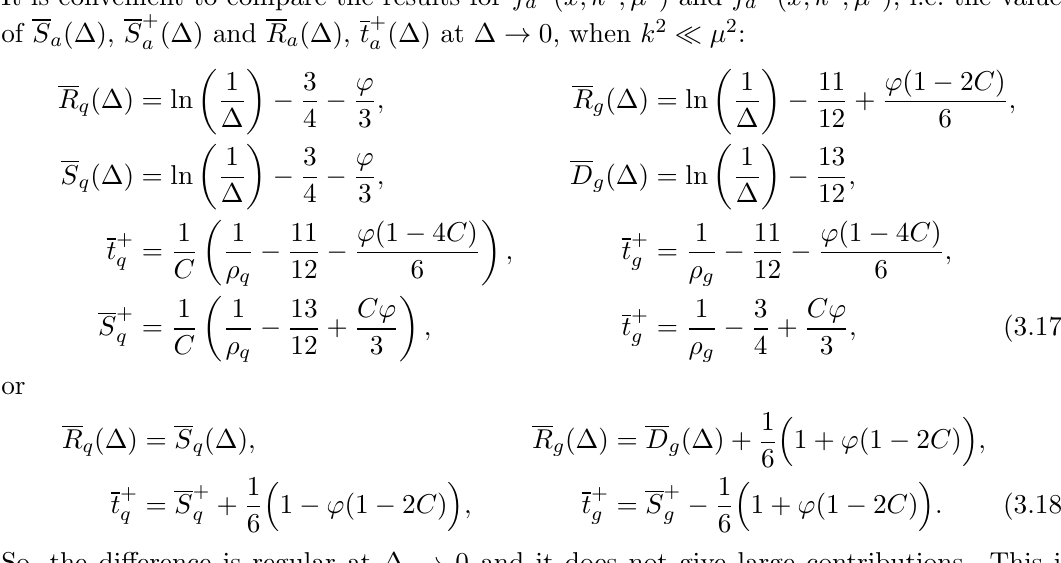
Figure 1 . The ratio of the TMD gluon densities in a proton obtained using integral and di(cid:11)erential formulation of the KMR approach as a function of the gluon transverse momentum k 2 values of longitudinal momentum fraction x and hard scale (cid:22) 2 . The angular ordering condition was